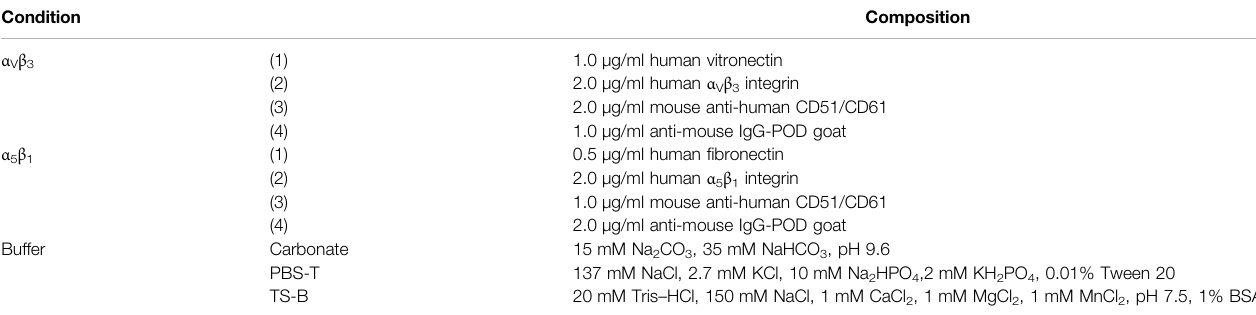
TABLE 1 | Proteins and buffers applied in the ELISA-like assay. Condition